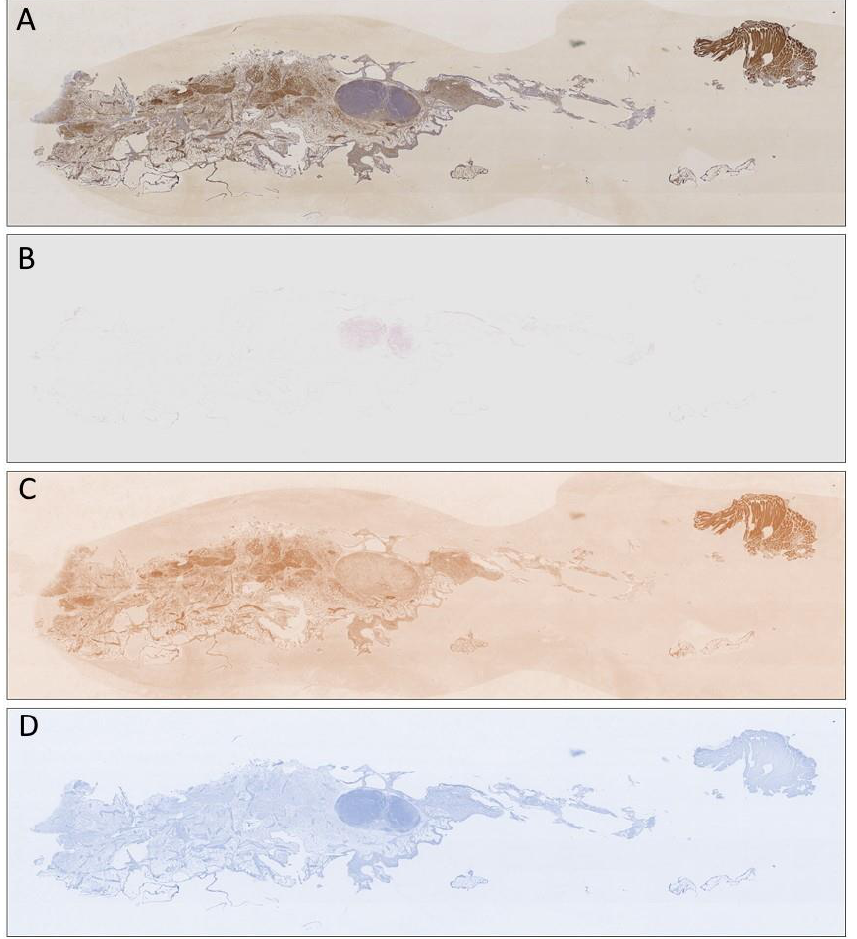
Figure 3. Example results of the applied color deconvolution in a diaminobenzidine ( DAB )-stained slide, illustrated in ( A ) color deconvolution artificially reproducing and separating the contributions of (B) FastRed , ( C ) DAB , and ( D ) FastBlue stains.